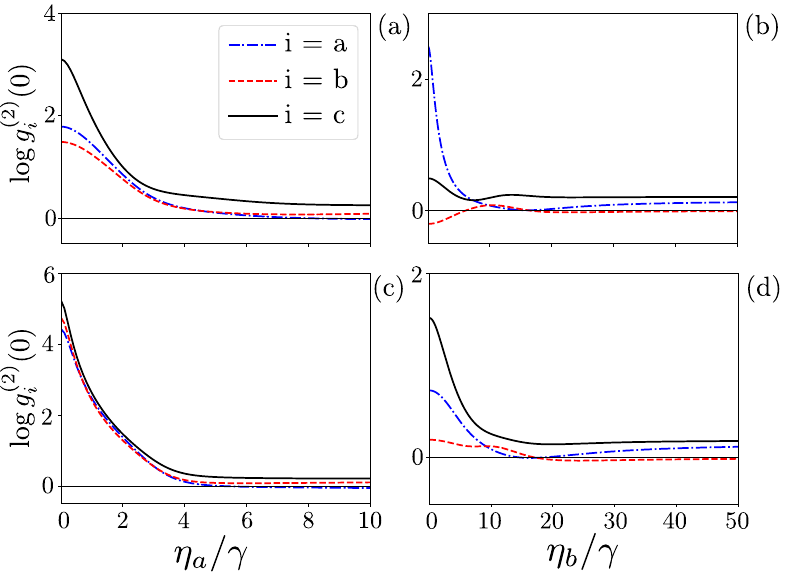
( 2 ) ( 0 ) versus the drive strengths: ( a , c ) η a for the SMR- Figure 11. Second-order correlation functions log g i 7.5 γ driven system and ( b , d ) η b for the QD-driven system. Parameters are given in: ( a ) Eq. (28) with g = 0 ; ( b ) Eq. (29) with ω p 1554 γ , which implies � q 3 γ , � b 1568 γ , which implies 6 γ , (cid:31) a and ω p = = = − = = (cid:31) q 7.5 γ and ω p 0 , � b 1551 γ , which implies (cid:31) q 0 , 8 γ , and � a 2 γ ; ( c ) Eq. (28) with g = = = = = − = � b 0 1570 γ , which implies � q 2 γ , � b 9 γ , and � a 3 γ ; and ( d ) Eq. (29) with ω p 10 γ , and (cid:31) a = = = − = = = −